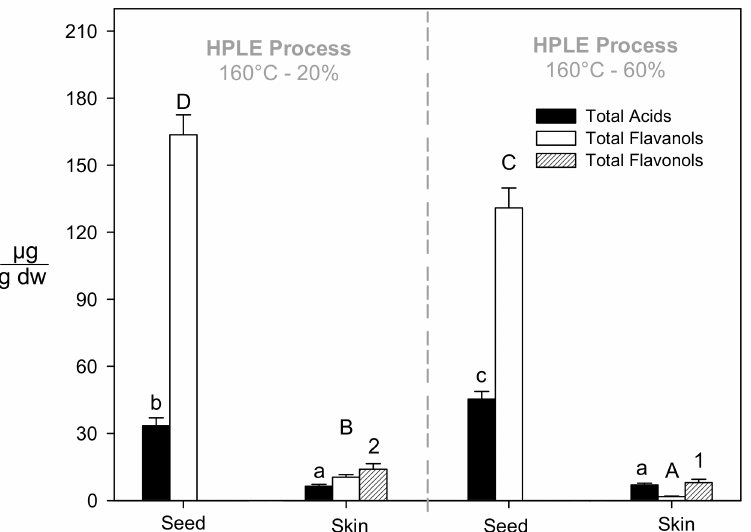
Figure 2. Specific polyphenol families recovered in the HPLE extracts at the highest temperature and maximum and minimum ethanol concentrations. The significant differences ( p < 0.05) between the different process conditions and grape pomace samples (seed or skin) were established with different lower-case letters, capital letters, and numbers for total acids, total flavanols, and total flavonols,